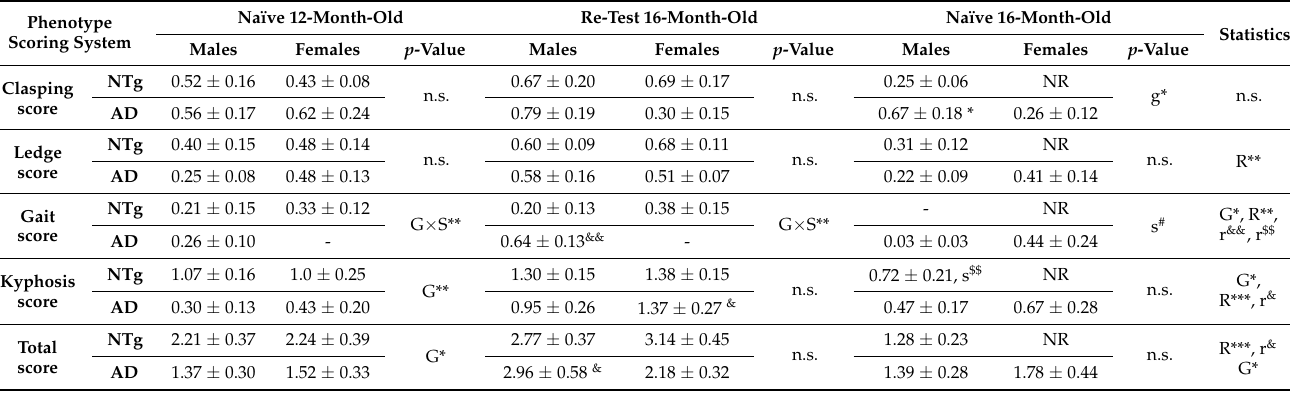
Table 1. Phenotype scoring